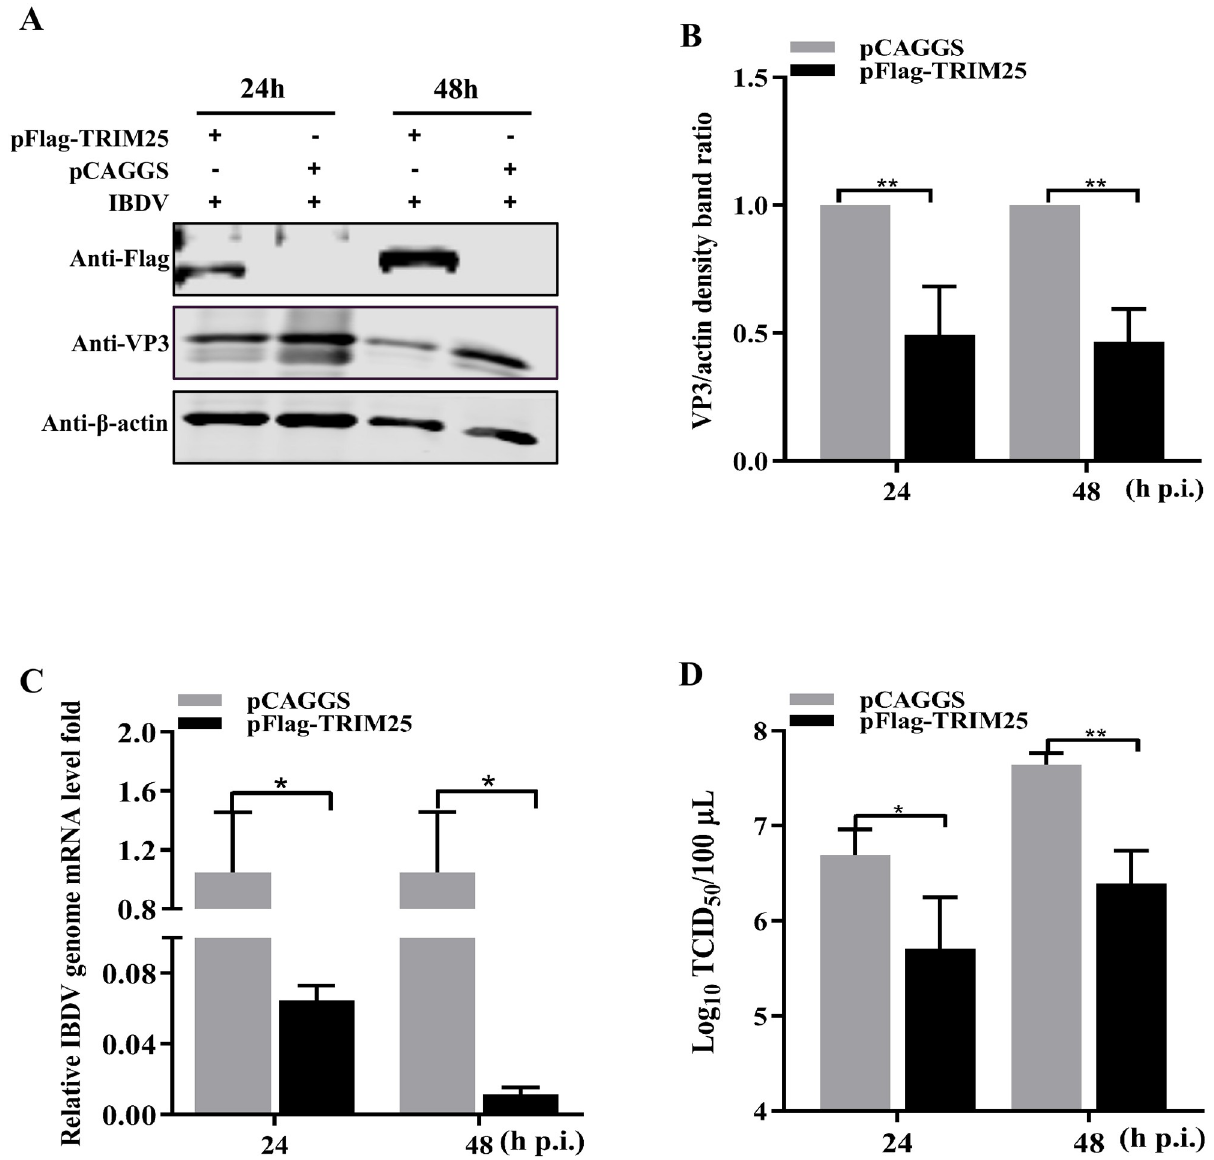
Fig 2. TRIM25 overexpression inhibits IBDV replication. (A-D) The influence of overexpression of pFlag-TRIM25 on IBDV replication. The DF-1 cells were transfected with 2 μ g pFlag-TRIM25 or pCAGGS at 24 h intervals and were infected with IBDV Gt strain at an MOI of 0.01. Subsequently, the cell and supernatant samples were collected at 24 and 48 h p.i, respectively. (A) Expression levels of TRIM25 and VP3 were determined by Western blotting. (B) Alternatively, relative intensities of VP3 were normalized to β -actin. (C) Relative fold-change of IBDV genome mRNA level of cell samples was quantified by RT-qPCR. (D) Released viral titer was detected and illustrated using a TCID 50 assay. All qPCR results are represented as relative fold changes after being normalized to β -actin controls. The Western blotting results are representative of one of three independently performed. Three independent experiments were performed, and data are shown as mean ± standard deviations for triplicates from representative experiments. � , P < 0.05; �� , P <